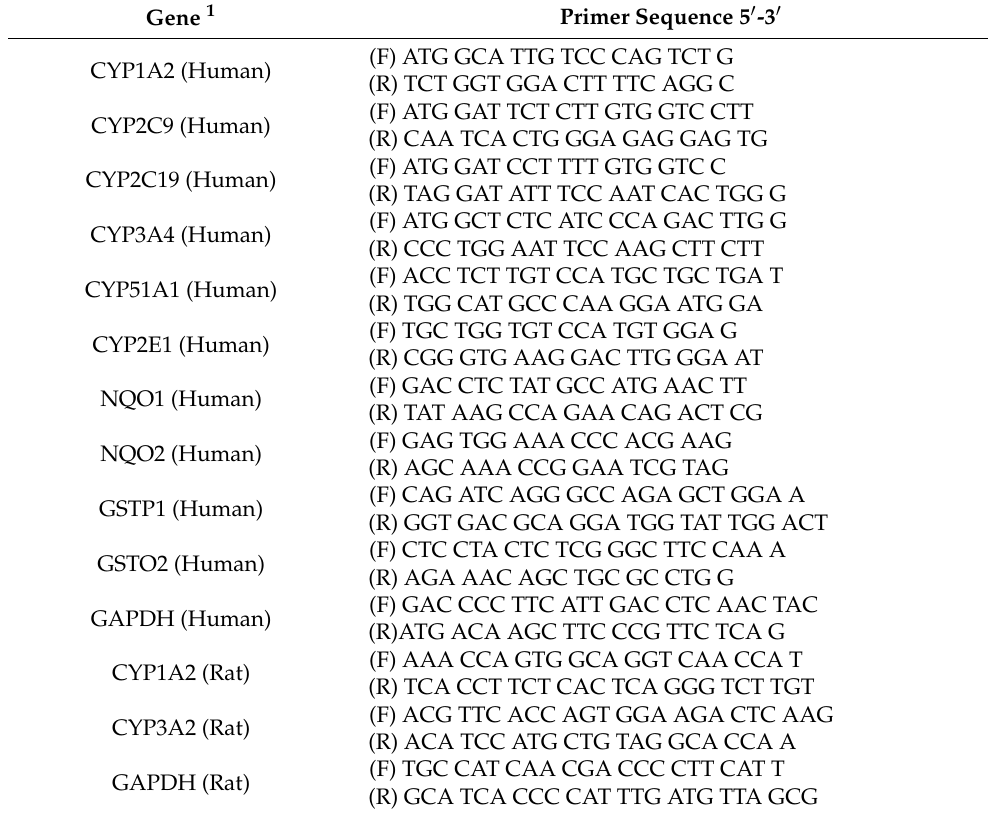
Table 1. Primers for real-time polymerase chain reaction analysis. Gene